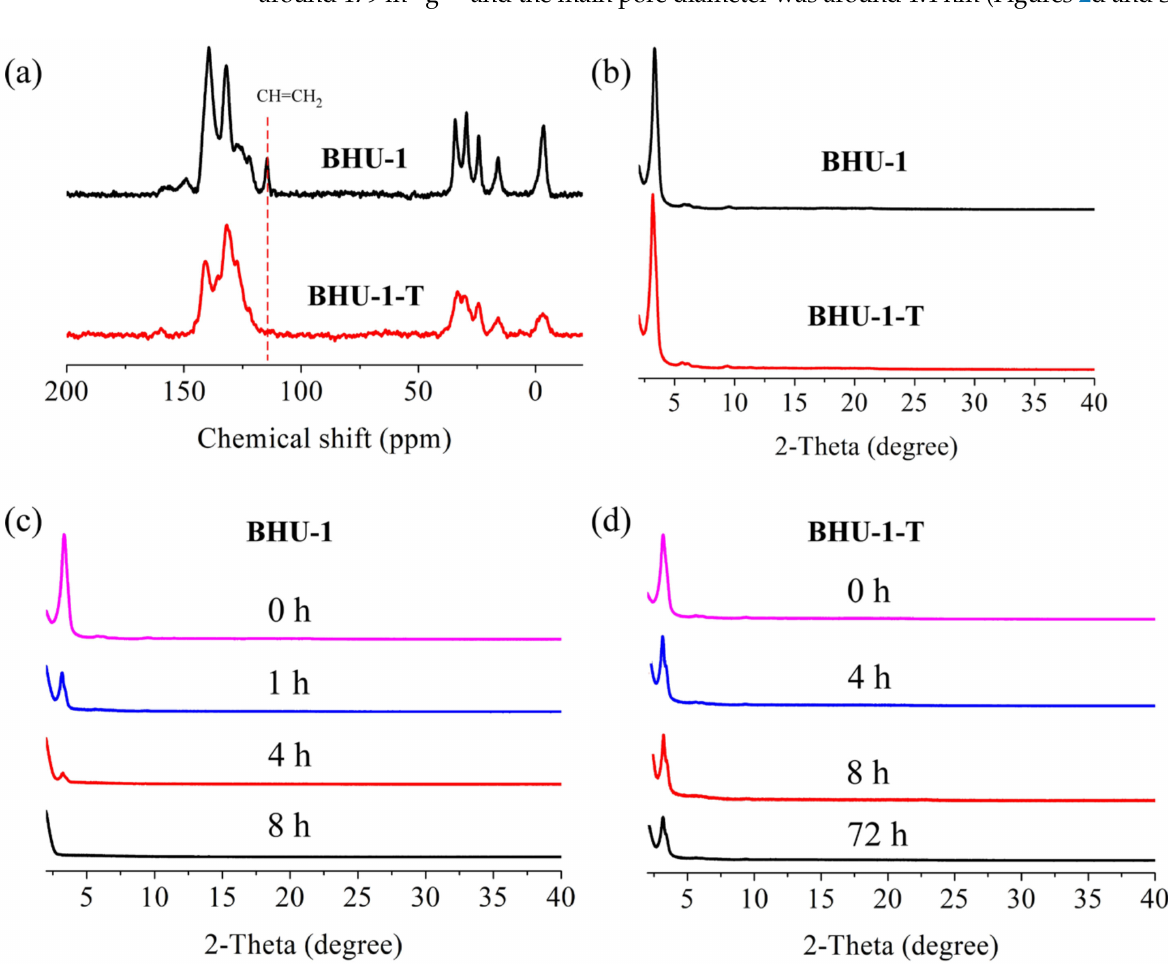
Figure 3. ( a ) 13 C CP-MAS solid-state NMR spectrum of BHU-1 and BHU-1-T for the identification of conversion of alkene groups through alkene metathesis. ( b ) PXRD patterns of BHU-1 and BHU-1-T. PXRD patterns of BHU-1 ( c ) and BHU-1-T ( d ) after treatment under acid conditions (in the mixture of 1 mL aqueous HCl (1 M) and 9 mL